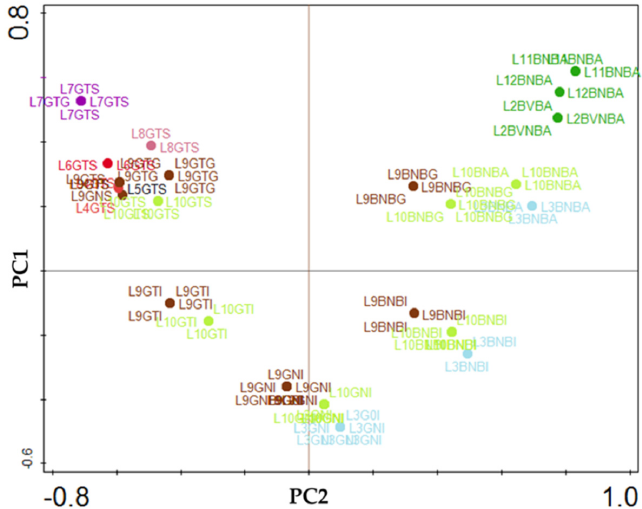
Figure 6. Plot of scores formed by principle component analysis, pertaining to LAB species (L1 = L. acidipiscis , L2 = L. brevis , L3 = L. casei , L4 = L. coryniformis , L5 = L. paracasei L6 = L. paracollinoides , L7 = L. parafarraginis , L8 = L. paraplantarum , L9 = L. pentosus , L10 = L. plantarum , L11 = L. veridesens , L12 = L. curvatus , L13 = L. rapi L14 = L. rhamnosus , L15 = L. vaccinostercus , L16 = L. fermentum ), olive color (G = green, B = black), type of processing treatment (N = natural, T = treated), and country of origin (A = Algeria, G = Greece; I = Italy; P = Portugal, S = Spain, T = Turkey).